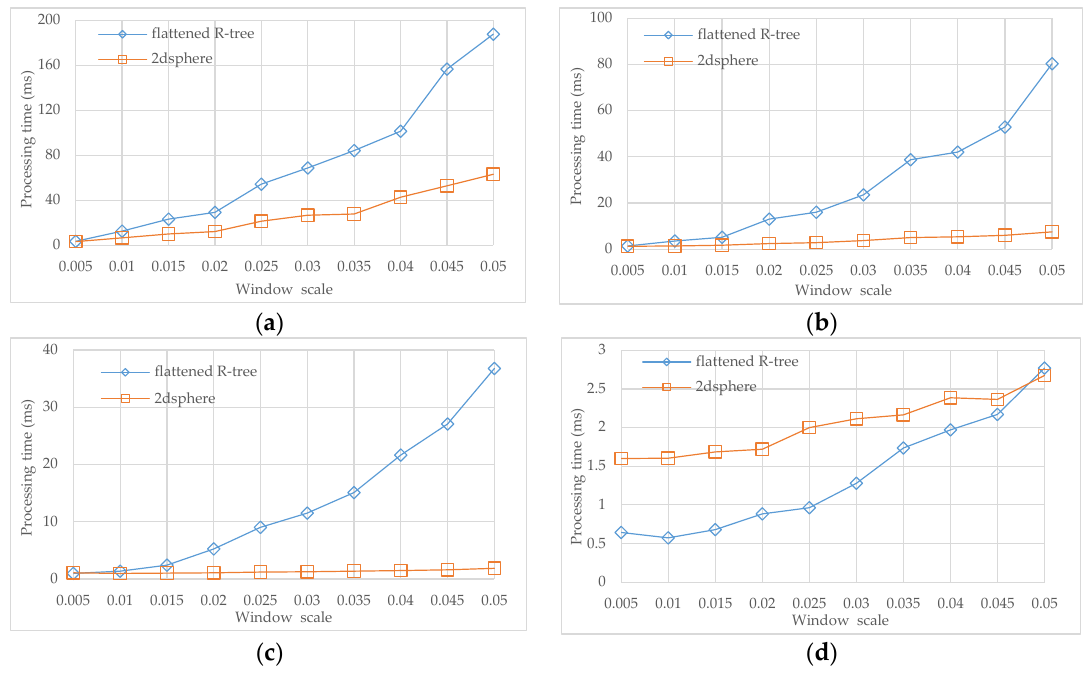
Figure 12. Comparison of the flattened R-tree with 2dsphere on query processing. ( a ) Washington DC building data; ( b ) Beijing street data; ( c ) Paris POI data; and ( d ) Wuhan Lake data.